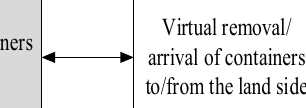
Figure 1. Model layout.